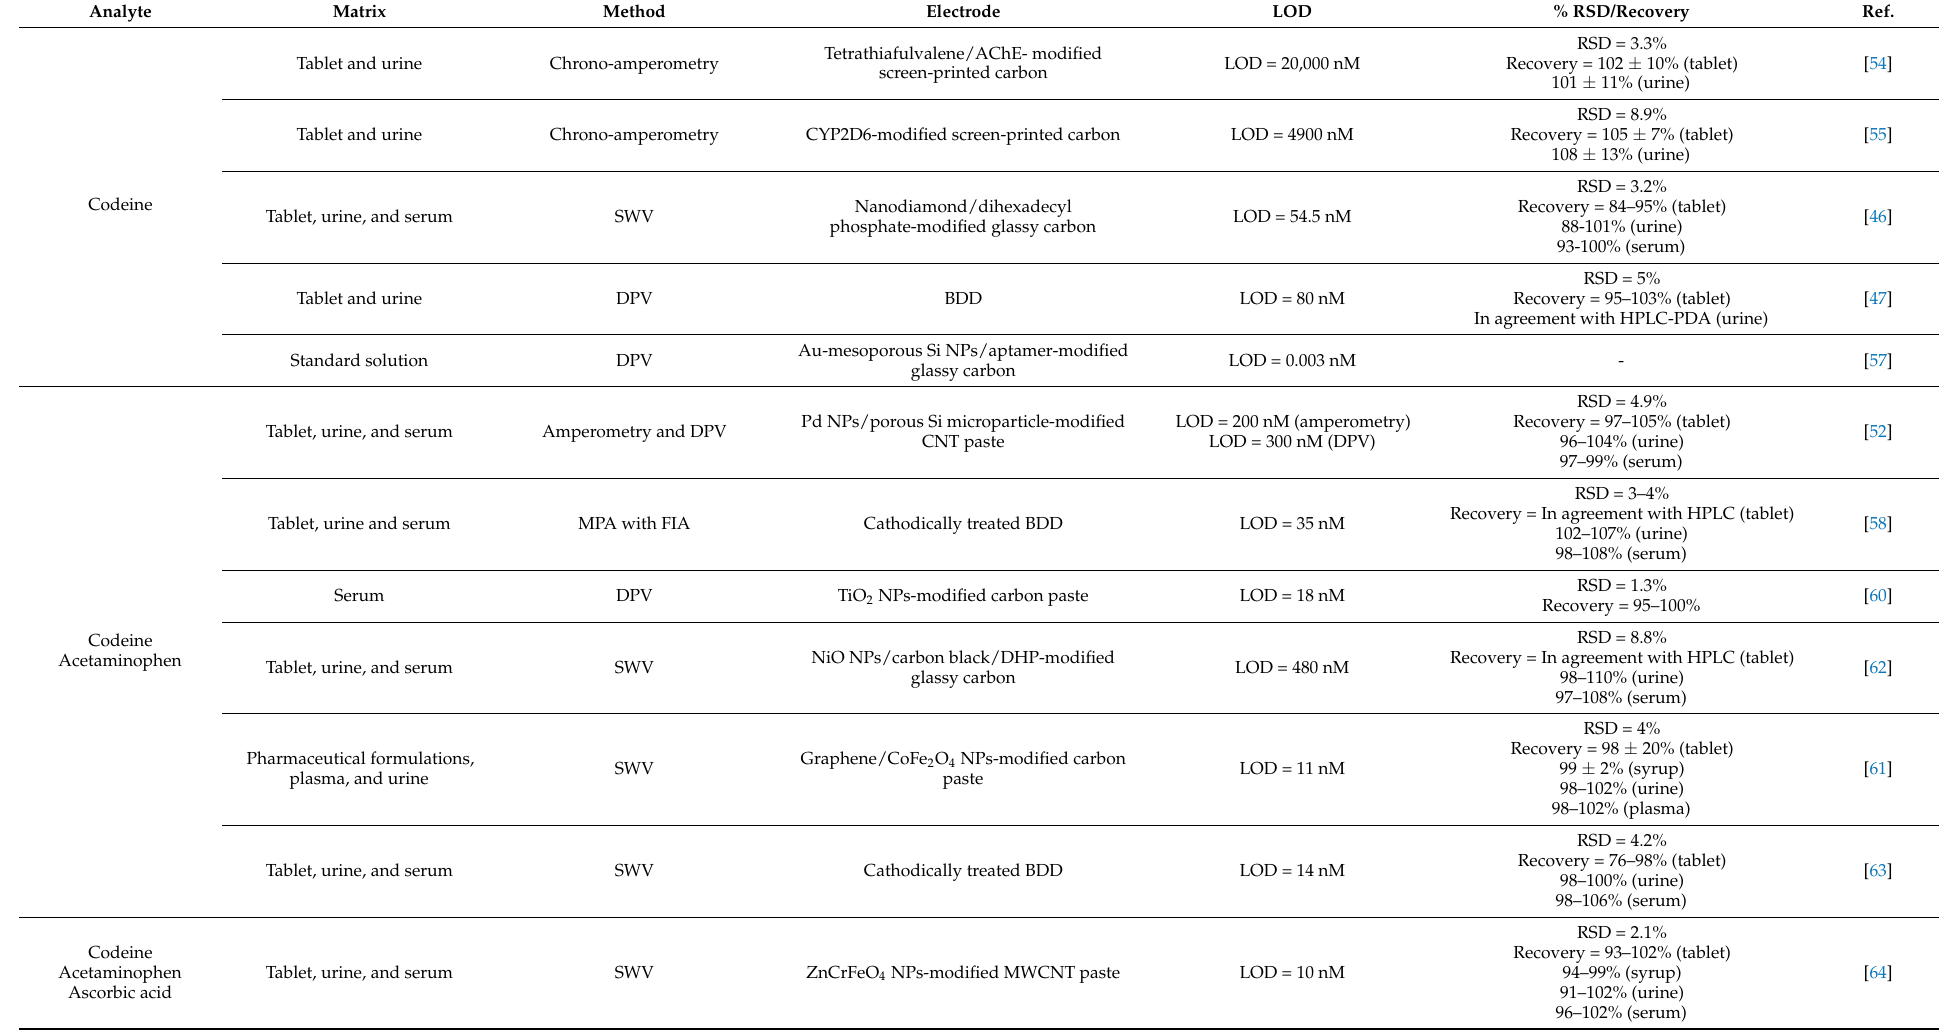
Table 3. Various electrochemical methods for codeine determination reported in the past